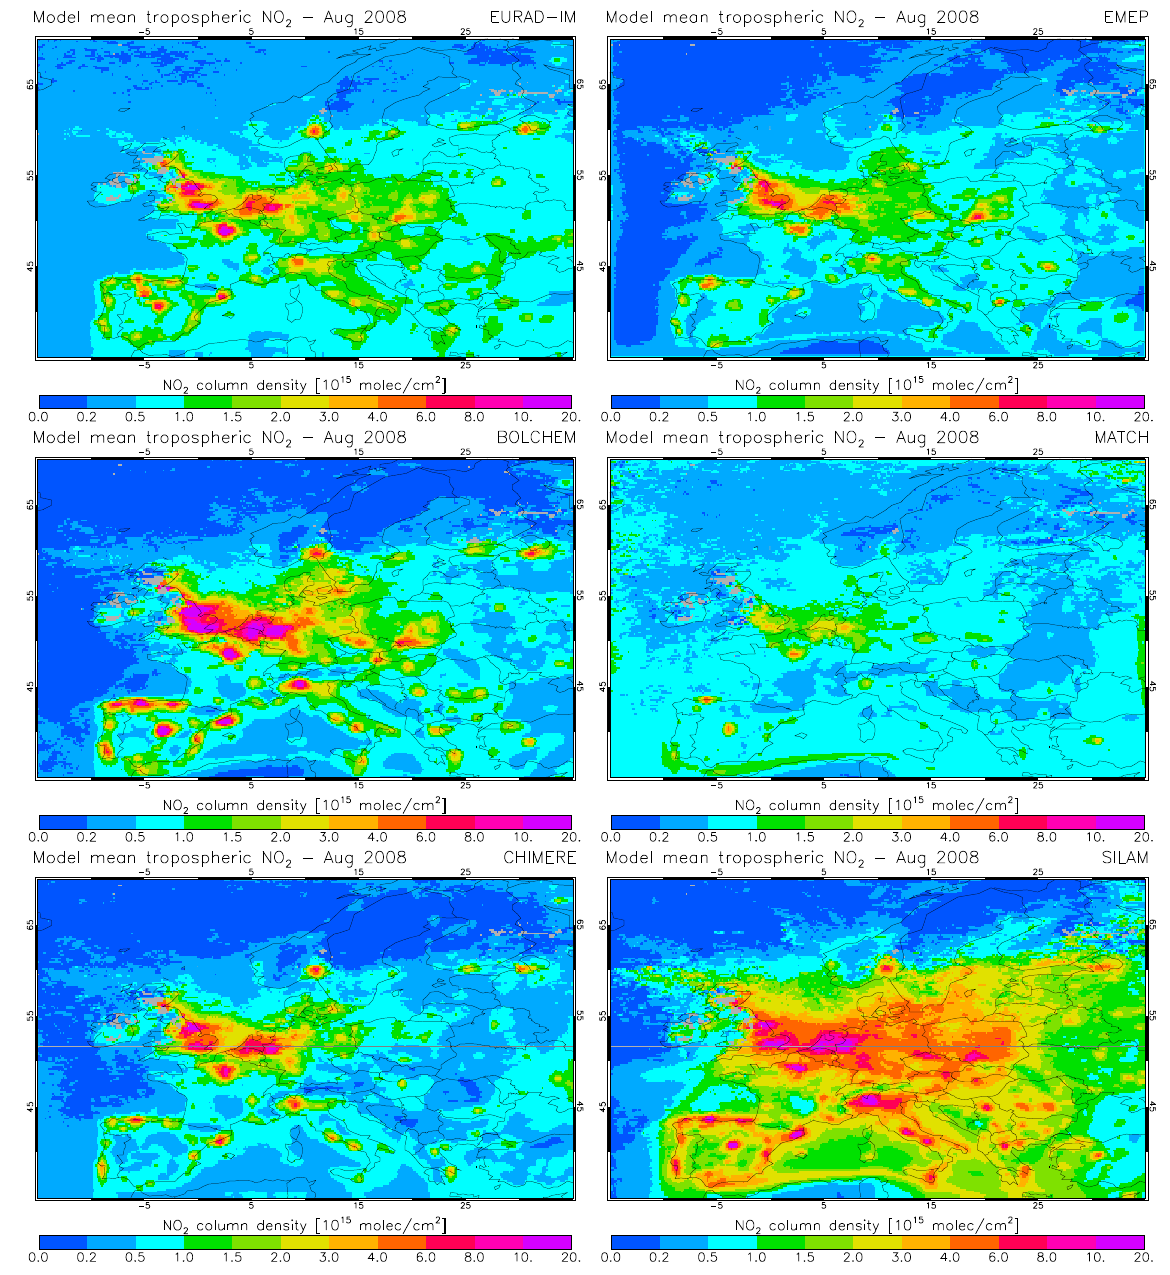
Fig. 4. Mean modeled tropospheric NO 2 columns in August for the contributing regional models.